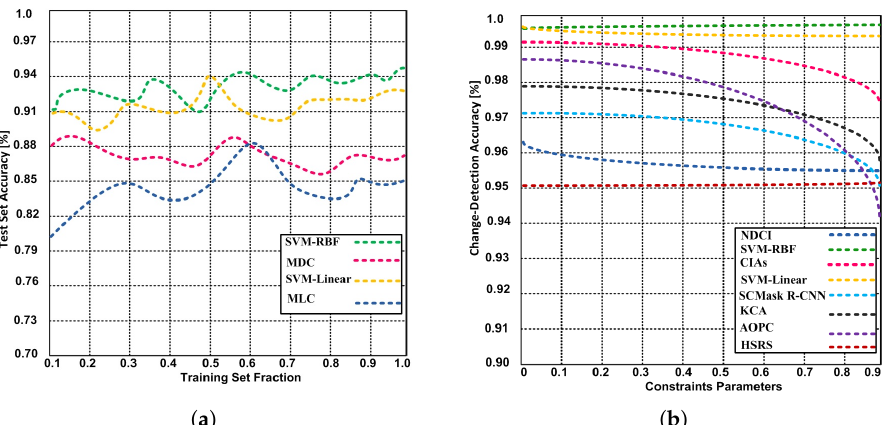
Figure 13. Accuracy. ( a ) Accuracy of the SVM-RBF, SVM-Linear, MLC and MDC approaches with different training set fractions. ( b ) The relationship between constraints parameters and change-detection accuracy of proposed SVM-RBF, SVM-Linear and competing algorithms.